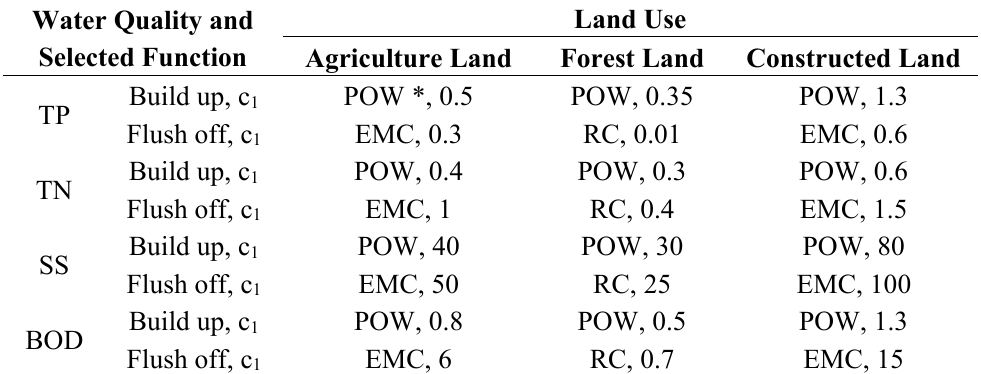
Table 3. Major model parameters for water quality simulation using SUSTAIN model and its verified values in this